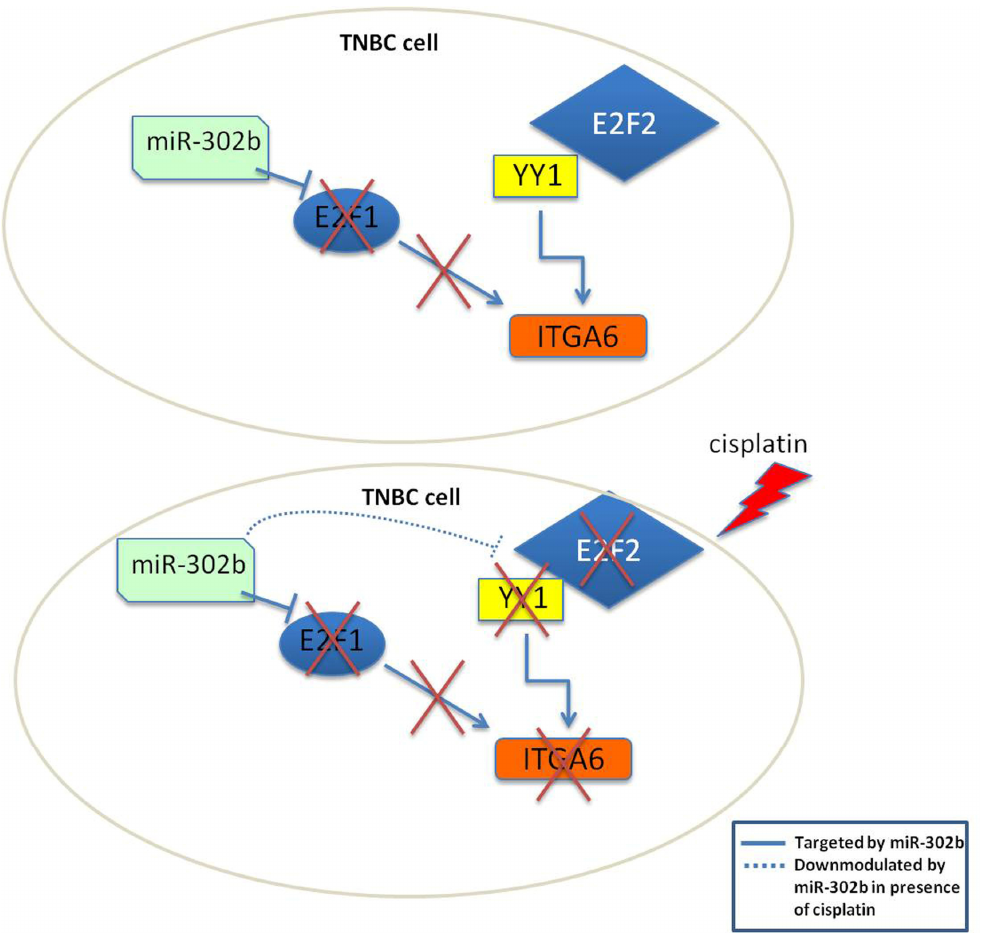
Figure 6. Schematic representation of proposed mechanism of action of miR-302b and cisplatin in TNBC cells. Upper scheme represents the biological activity of miR-302b in monotherapy. Exogenous expression of miR-302b does not a ff ect ITGA6, since YY1 can interact with E2F2 to maintain ITGA6 transcription. Lower scheme represents the e ff ect of combined intervention of miR-302b and cisplatin, that results in YY1 and E2F2 down-modulation impeding their activity over ITGA6 and leading to TNBC cell death. This proposed mechanism acts together with the well-known E2F1 down-modulation, another predicted ITGA6 TF, by